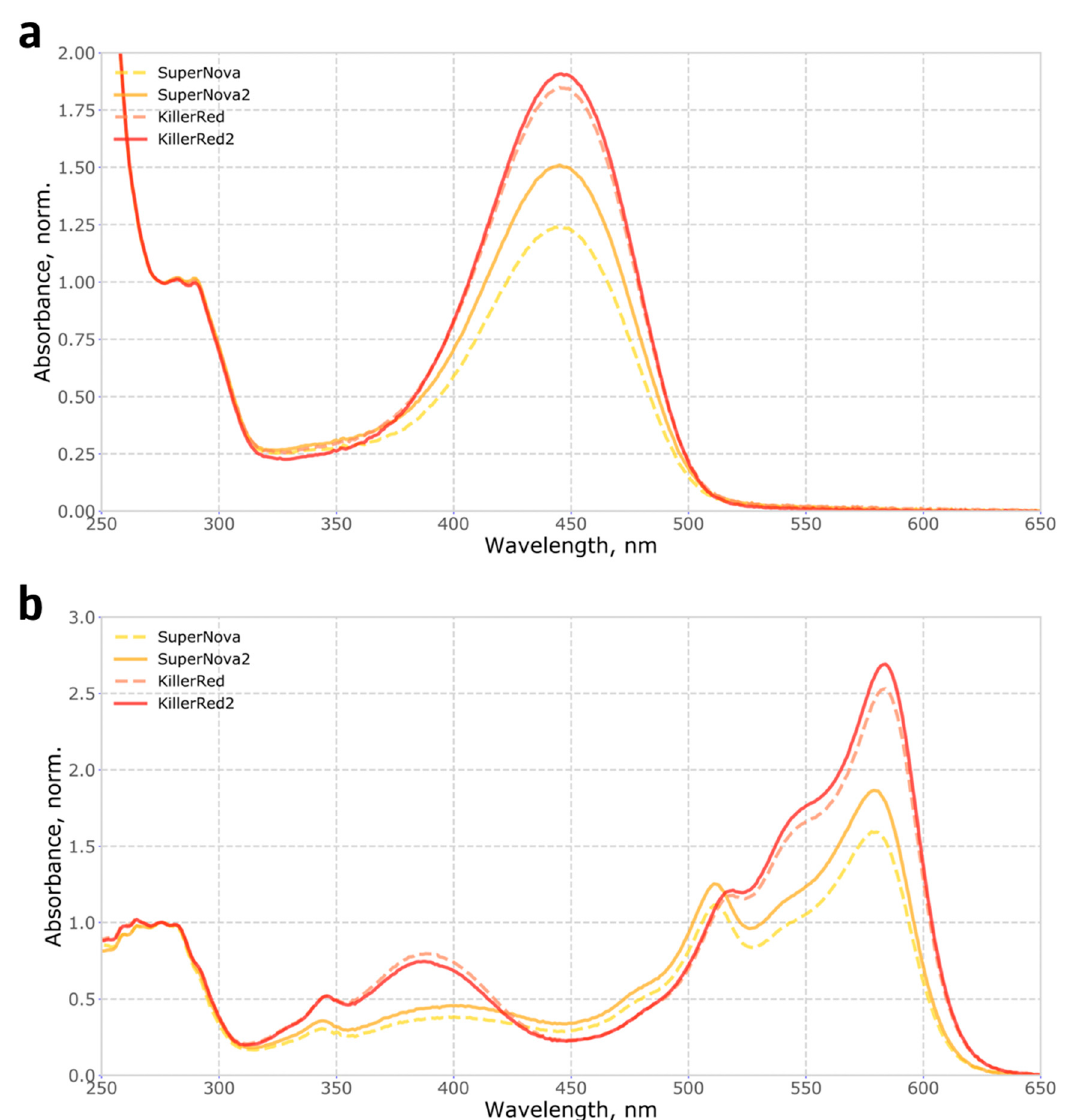
Figure 1. Absorbance spectra of native and alkali-denatured recombinant SuperNova, SuperNova2, KillerRed and KillerRed2 proteins: ( a ) Absorbance spectra of proteins denatured in 1 M NaOH, normalized to 280 nm; ( b ) Absorbance spectra of native proteins, in PBS, normalized to 280 nm.